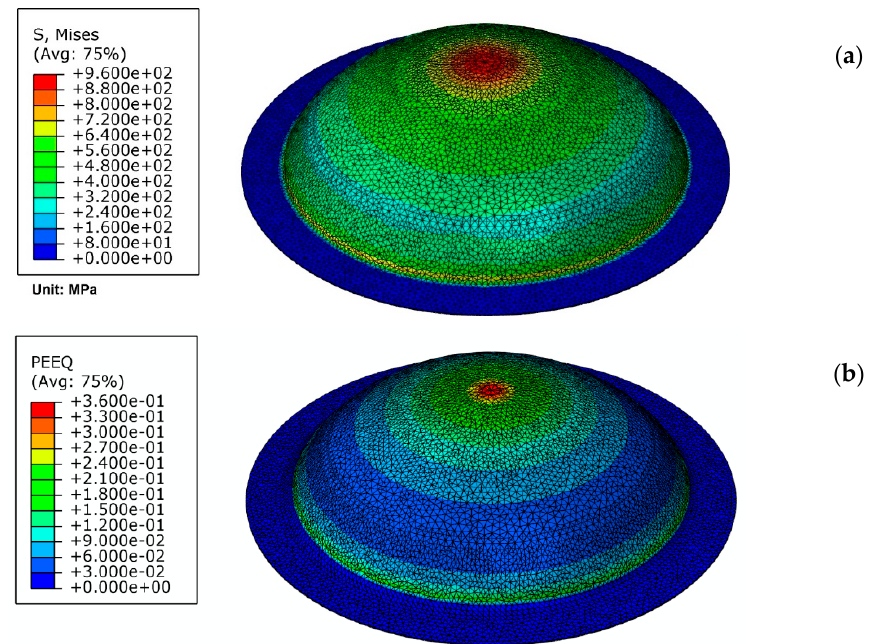
Figure 11. The equivalent stress ( a ) and the corresponding equivalent strain distributions on the domed rupture disc at 300 K ( b ).